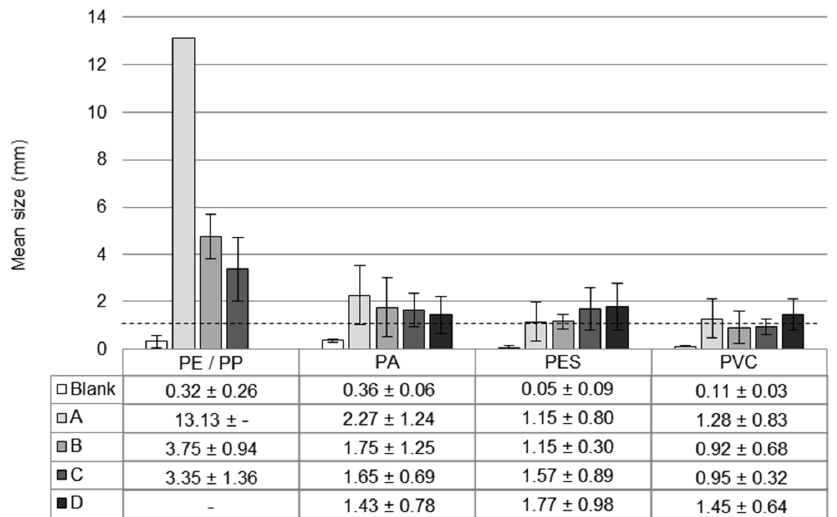
Figure 6. Mean size of microplastics and agglomerates. The dashed black line marks the 1 mm limit from which the microplastics are assessed as removed. (A = PE-X; B = n-Butyltrichlorosilane; C = Isooctyltrichlorosilane; D = (3-Chloropropyl) trichlorosilane). Ma et al. 2019 reported flock sizes of 258.6 ± 20.8 µm using aluminium-based floccu- lants and 474.8 ± 25.6 for iron-based flocculants for the removal of PE. Lapointe et al. 2020 reported flock diameters of 977 ± 36 µm for the removal of PE < 140 µm and of 504 ± 18 µ m for PE > 140 µ m applying polyacrylamide-based flocculants. Compared to this, using organosilanes higher agglomerate sizes could be reached for the removal of PE/PP with up to 13,130 µ m using PE-X. Also it is notable that on pilot plant scale much higher agglomerate sizes could be achieved [25]. This is a big advantage of this method, as larger agglomerates can be removed more